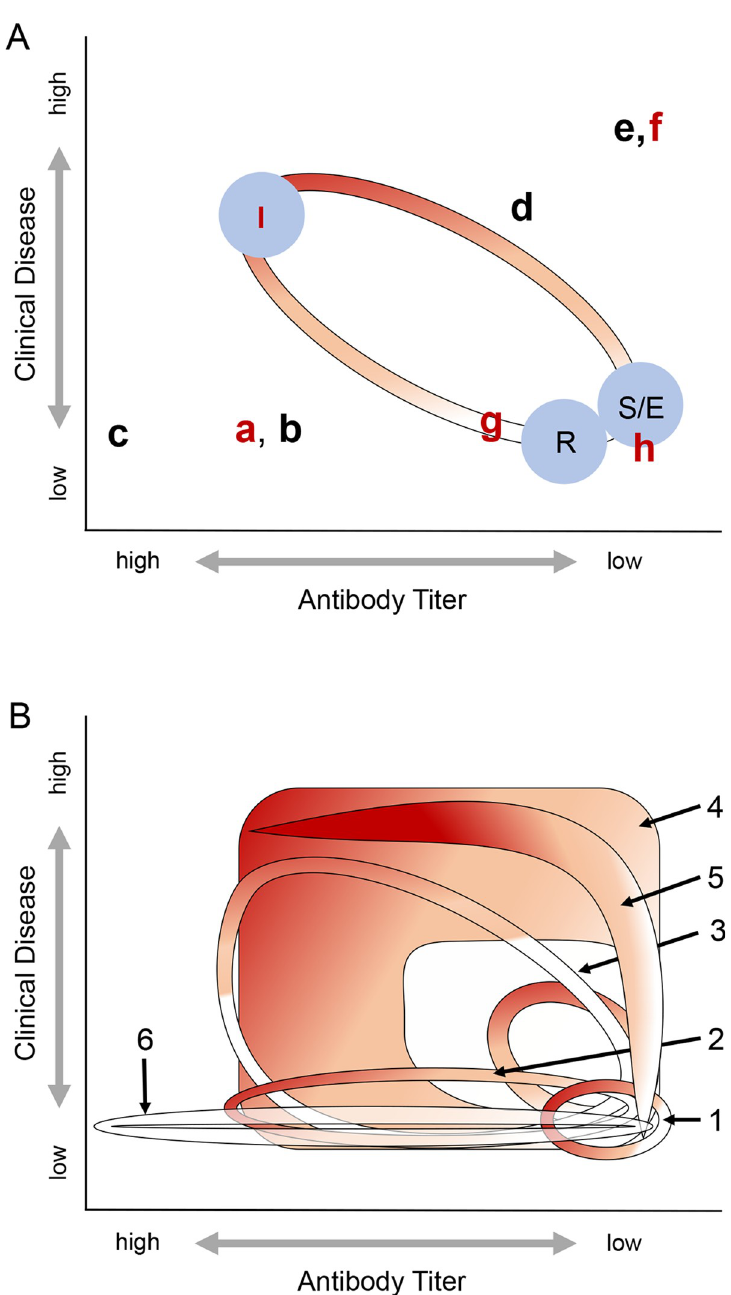
Fig 2. Maps showing how infected individuals move through the “host-pathogen space” in dimensions reflecting severity of clinical disease (y-axis) and time since infection (~antibody titer, x-axis). When susceptible individuals become infected (indicated by red shading–the intensity of shading indicates the probability that an assay for current infection–e.g. PCR–would be positive), they move through this space in a trajectory towards higher titer and more severe clinical disease states and then, depending on the type of pathogen and the host-pathogen interaction, they eventually return to a state of good health and their titers decline. The shape of this trajectory and their infection state will differ based on the host-pathogen system and the degree of heterogeneity in host responses. (A) shows the trajectory that would be expected based on the canonical SEIR model of infectious disease dynamics, with the position of individuals as they would pass through each of the four states–S, E, I, and R–indicated by the blue circles. Lower case letters a - h , representing individuals described in Table 1, show how individuals experiencing more complex host- pathogen interactions may fall outside of this canonical trajectory. (B) shows examples of alternative trajectories that individuals might trace through this host pathogen space, which can encompass these ambiguous states. Numbers correspond to those referenced in the text of Fig 1 and red shading is as described for